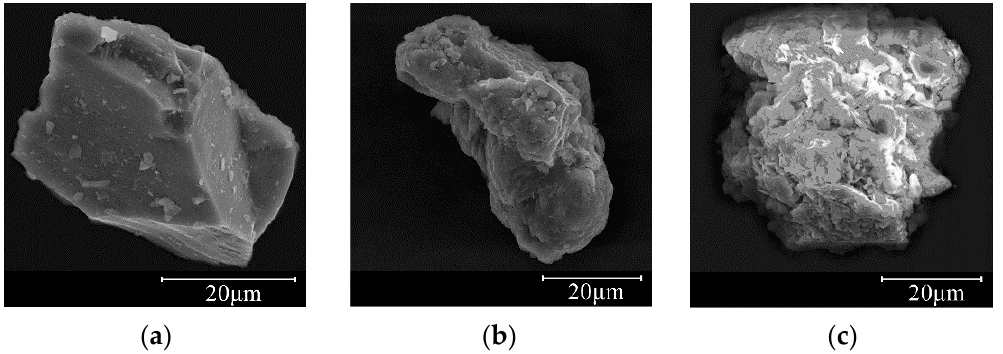
Figure 5. Micro surface texture morphologies of the mineral filler particles. ( a ) Granite filler (5000×) ; ( b ) Diabase filler (3000×) ; ( c ) Limestone filler (2500×) .